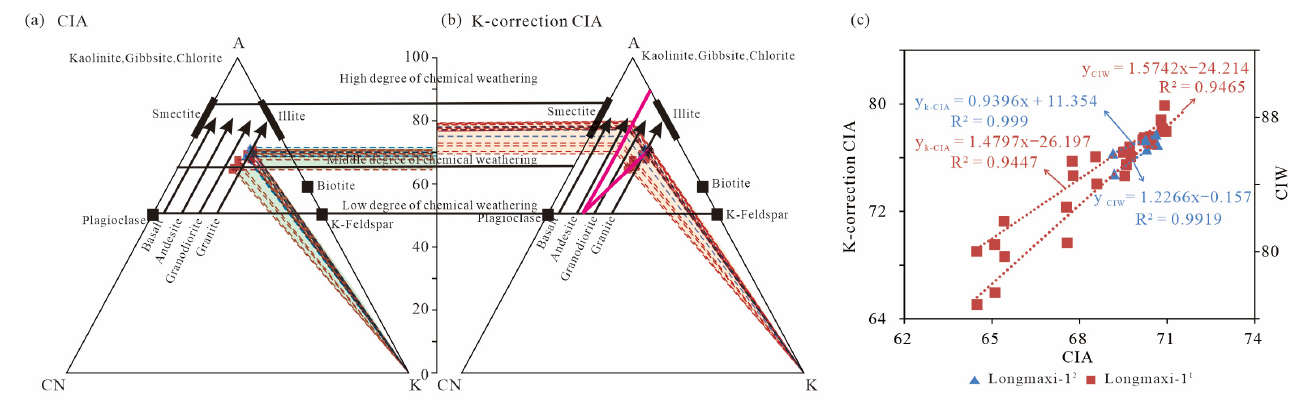
Figure 3. The discrimination diagram of potassium metasomatism in black shales of Longmaxi-1 during diagenesis. ( a ) A-CN-K with uncorrected data [41]; ( b ) A-CN-K with K-corrected data [49]; ( c ) CIA-(K-correction CIA)/CIW [41,49,57].